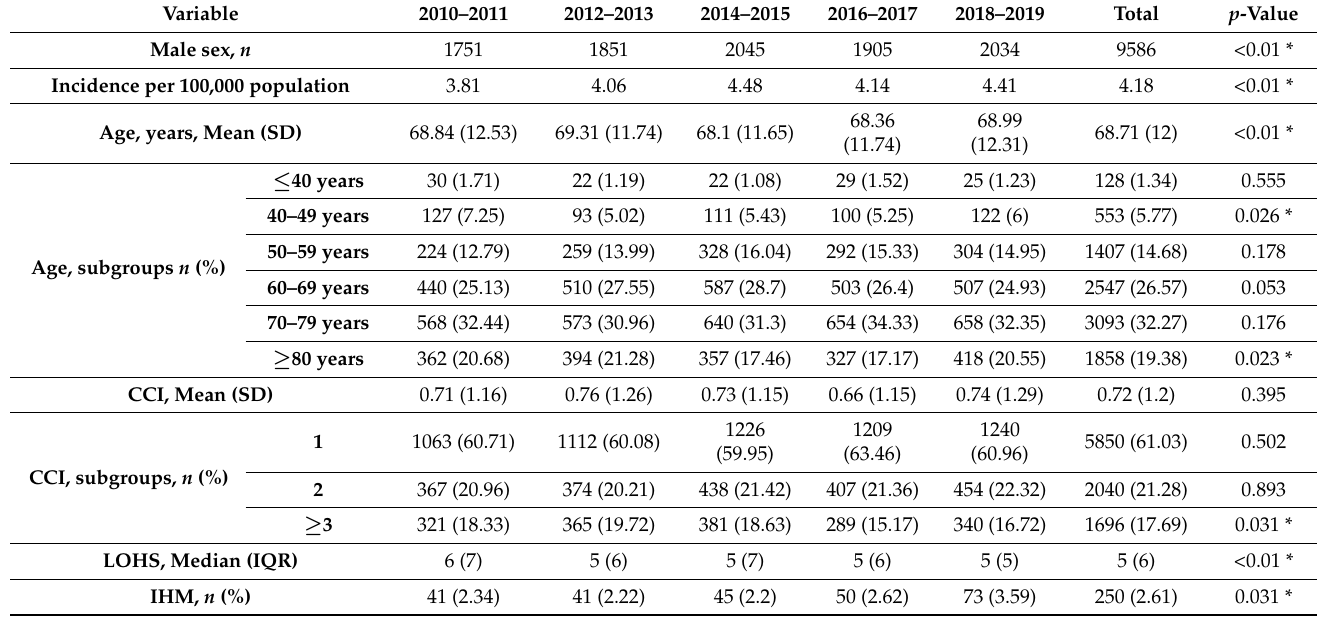
Table 2. Characteristics of Hospital Admissions of Male Patients with Parkinson’s Disease as a Primary Diagnosis in Spain (2010–2019).